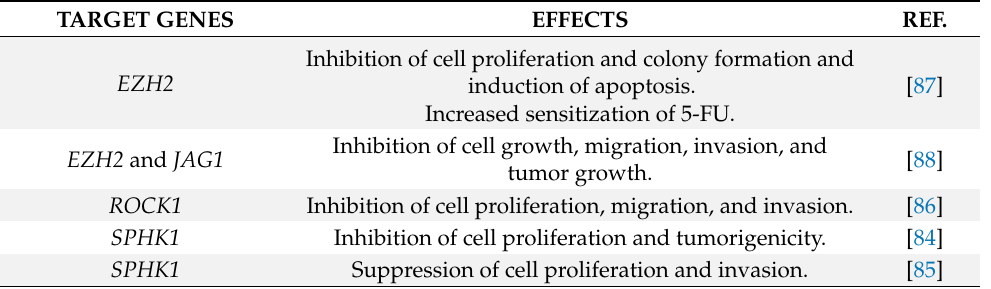
Table 5. Anti-tumor function of miR-124 in gastric cancer.